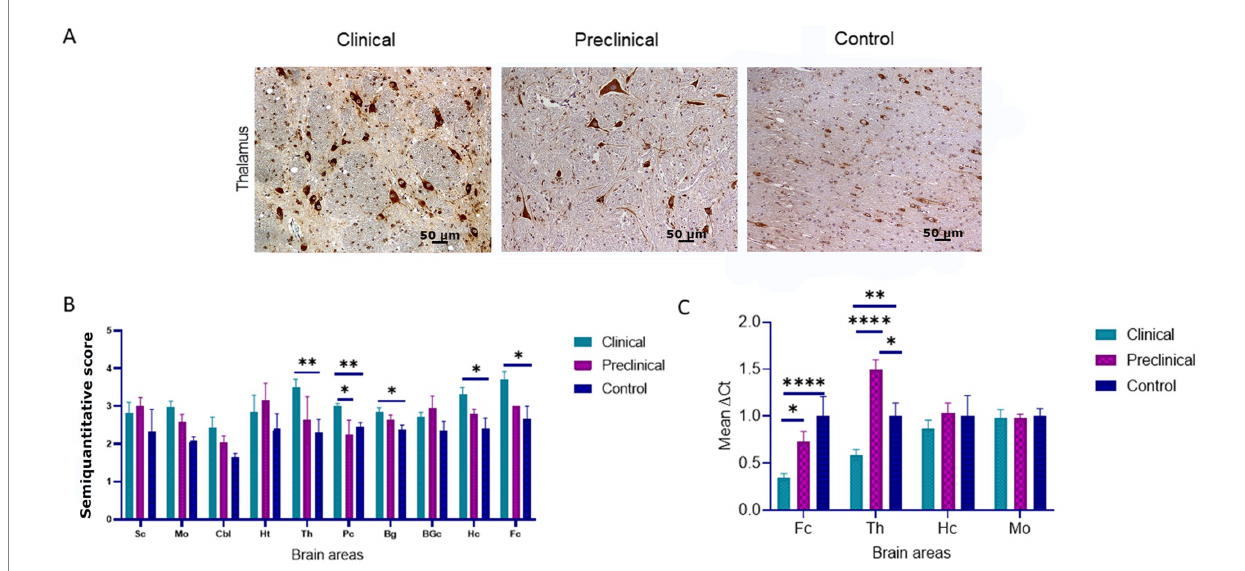
FIGURE 2 Binding immunoglobulin protein (BiP) expression in clinical and preclinical scrapie-infected sheep and control sheep. (A) Immunohistochemical detection of BiP in clinical, preclinical and control groups. Representative images correspond to the thalamus. Intense deposits of BiP protein were observed in the cytoplasm of neurons in clinical and preclinical sheep. (B) Expression levels of BiP in eight clinical, five preclinical and eight control animals were evaluated using the following semi-quantitative scoring system a rating of 0 (lack of immunostaining) to 5 (very intense immunostaining) in nine brain areas: spinal cord (Sc), medulla oblongata (Mo), cerebellum (Cbl), hypothalamus (Ht), thalamus (T), parietal cortex (Pc), basal ganglia (BG), cortex at the level of basal ganglia (BGc), hippocampus (Hc) and frontal cortex (Fc). Clinical sheep showed significantly higher deposition of BiP when compared with preclinical and control animals (* p < 0.05, ** p < 0.01, Mann–Whitney U test). (C) mRNA expression profiles of the HSPA5 gene in frontal cortex, thalamus, hippocampus and medulla oblongata of clinical, preclinical, and control sheep. Relative expression levels are expressed as the mean ± standard deviation. The results were normalized using the expression of SDHA and GAPDH housekeeping genes. The expression values were determined using the 2 −∆∆ Ct method, and differences between experimental groups were assessed using the one-way ANOVA test followed by the Bonferroni post hoc test (* p <